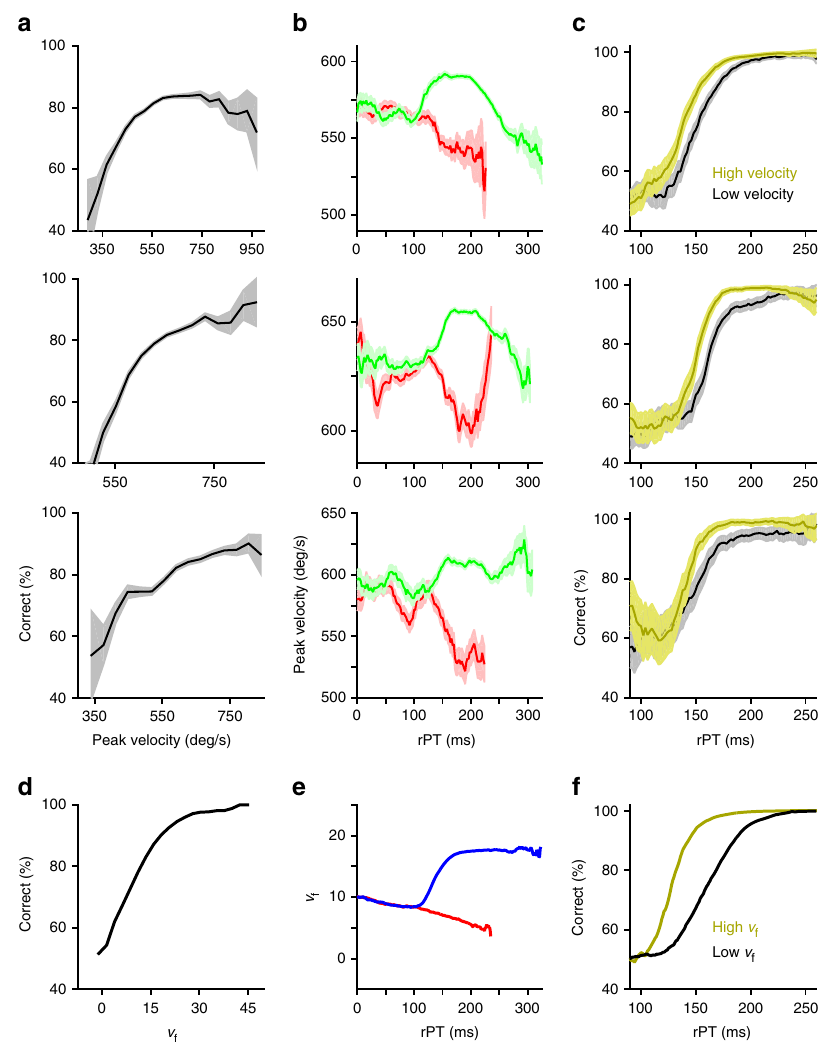
Fig. 8 Saccade peak velocity and simulated oculomotor neural data correlate with the probability that a choice is correct, given the perceptual evidence. a Percentage of correct responses as a function of saccade peak velocity for each of the three subjects. b Mean (±1 s.e.m.) peak velocity of correct (green) and incorrect (red) saccadic choices as a function of rPT (previously shown in Fig. 3a). c Percentage of correct responses as a function of rPT for trials with peak velocities above (gold) and below (black) the median peak velocity. Error bars in c represent 95% binomial proportion con fi dence intervals. d Percentage of correct responses as a function of the derivative of simulated neural activity at threshold crossing ( v f ). e Mean v f of correct (blue) and incorrect (red) simulated trials as a function of rPT. f Percentage of correct simulated trials as a function of rPT for trials with high (above median) and low (below median) v f . Data are from monkeys R, T, and G (rows 1 – 3). Simulations (row 4) were based on the behavioral data from subject R. For all